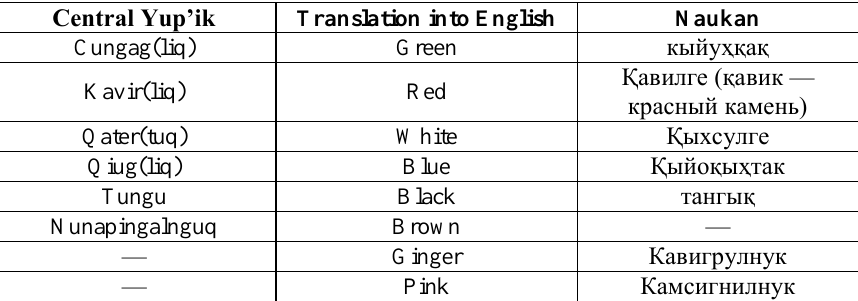
Table 1 – Linguistic units/terms of colours (Naukan and Central Yup’ik)